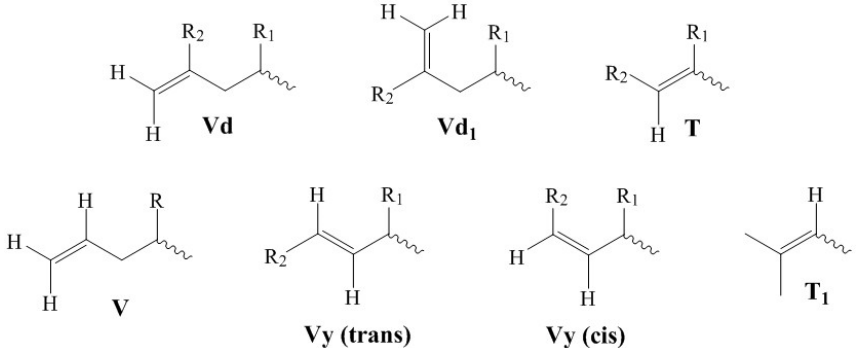
Scheme 2. Chain-end groups.